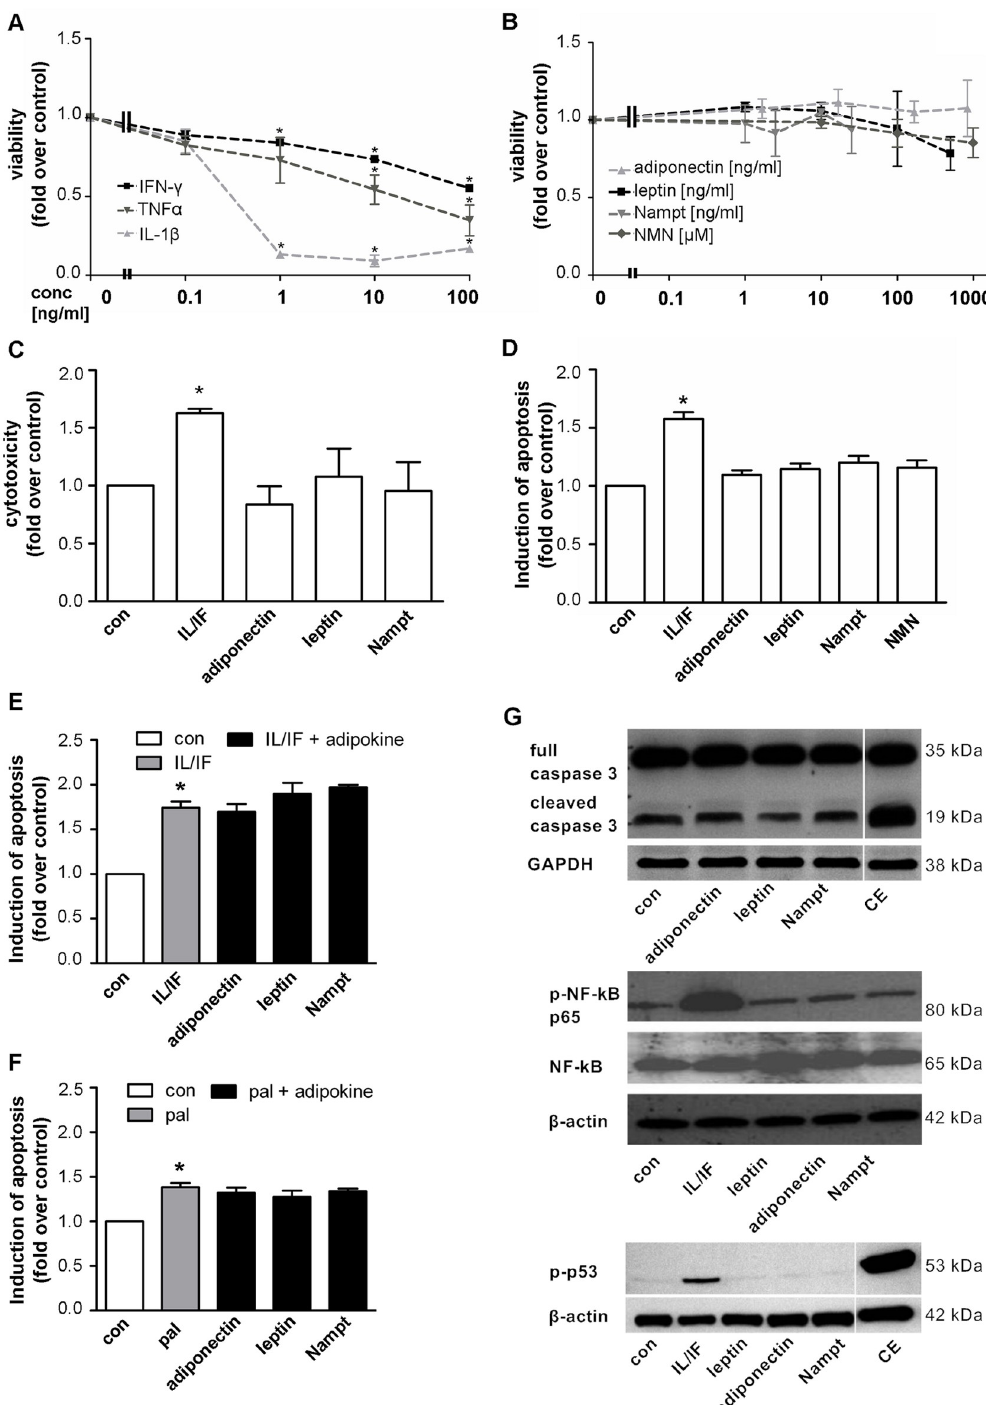
Fig 1. The adipocytokines leptin, adiponectin, Nampt and NMN have no direct effects on beta-cell survival in INS-1E cells. INS-1E cells were kept under serum-free conditions 24 h before and during the 48 h experiment. ( A,B ) INS-1E cells were exposed to cytokines ( A : IL-1 β , IFN- γ or TNF α ) or adipocytokines ( B : adiponectin, leptin, Nampt, NMN) at the indicated concentrations for 48 h and cell viability was measured by WST-1 assay. Data are shown as means ± SEM of 3 independent experiments performed in triplicates. Statistical analyses were performed by one-way ANOVA with Bonferroni’s Multiple Comparison Test as posthoc test. C,D : INS-1E cells were exposed to adipocytokines (adiponectin 167 ng/ml, leptin